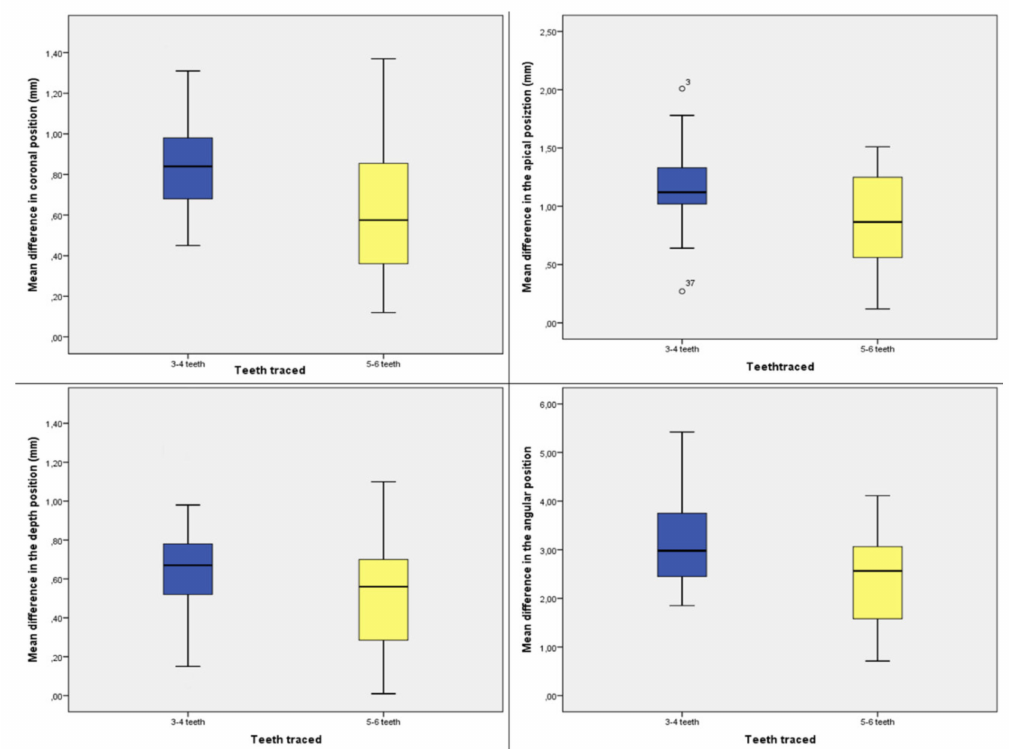
Figure 9. Box plots showing the median, quartile, and minimum and maximum values of the mean di ff erences between the planned implants and inserted implants in patients with 3–4 or 5–6 teeth left in the coronal position of implants (mm), the apical position of implants (mm), depth of implants (mm), and angle of implants.